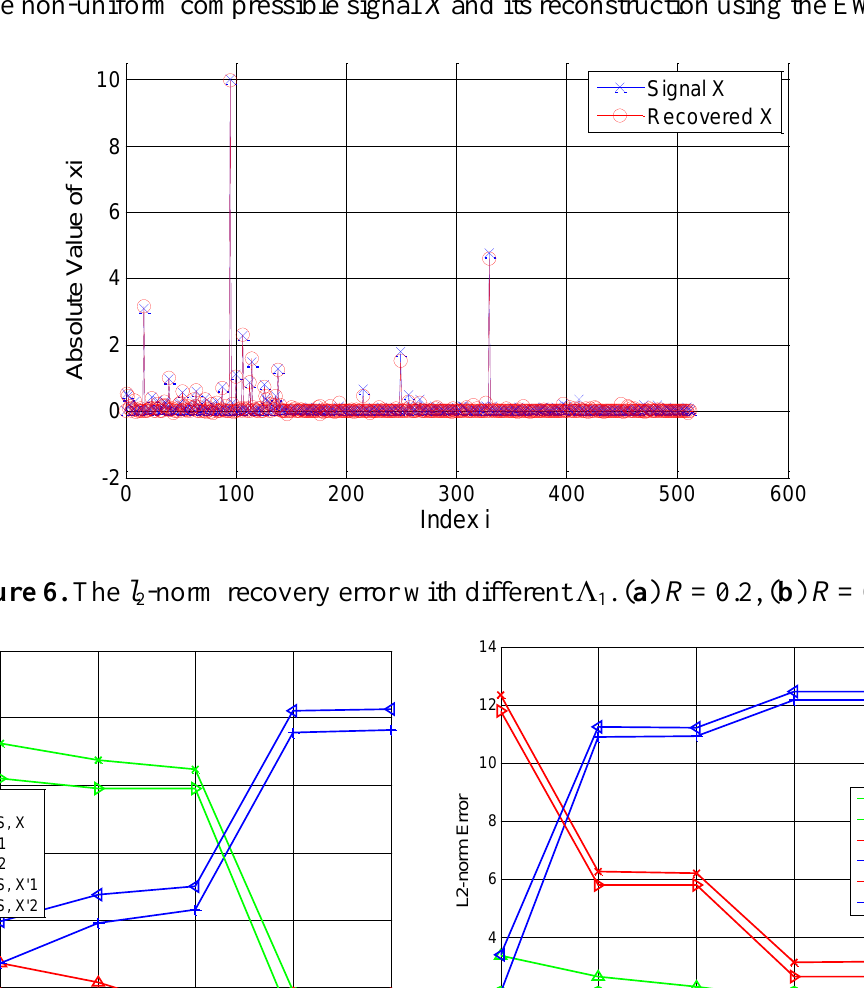
Figure 5. The non-uniform compressible signal X and its reconstruction using the EW-CS.